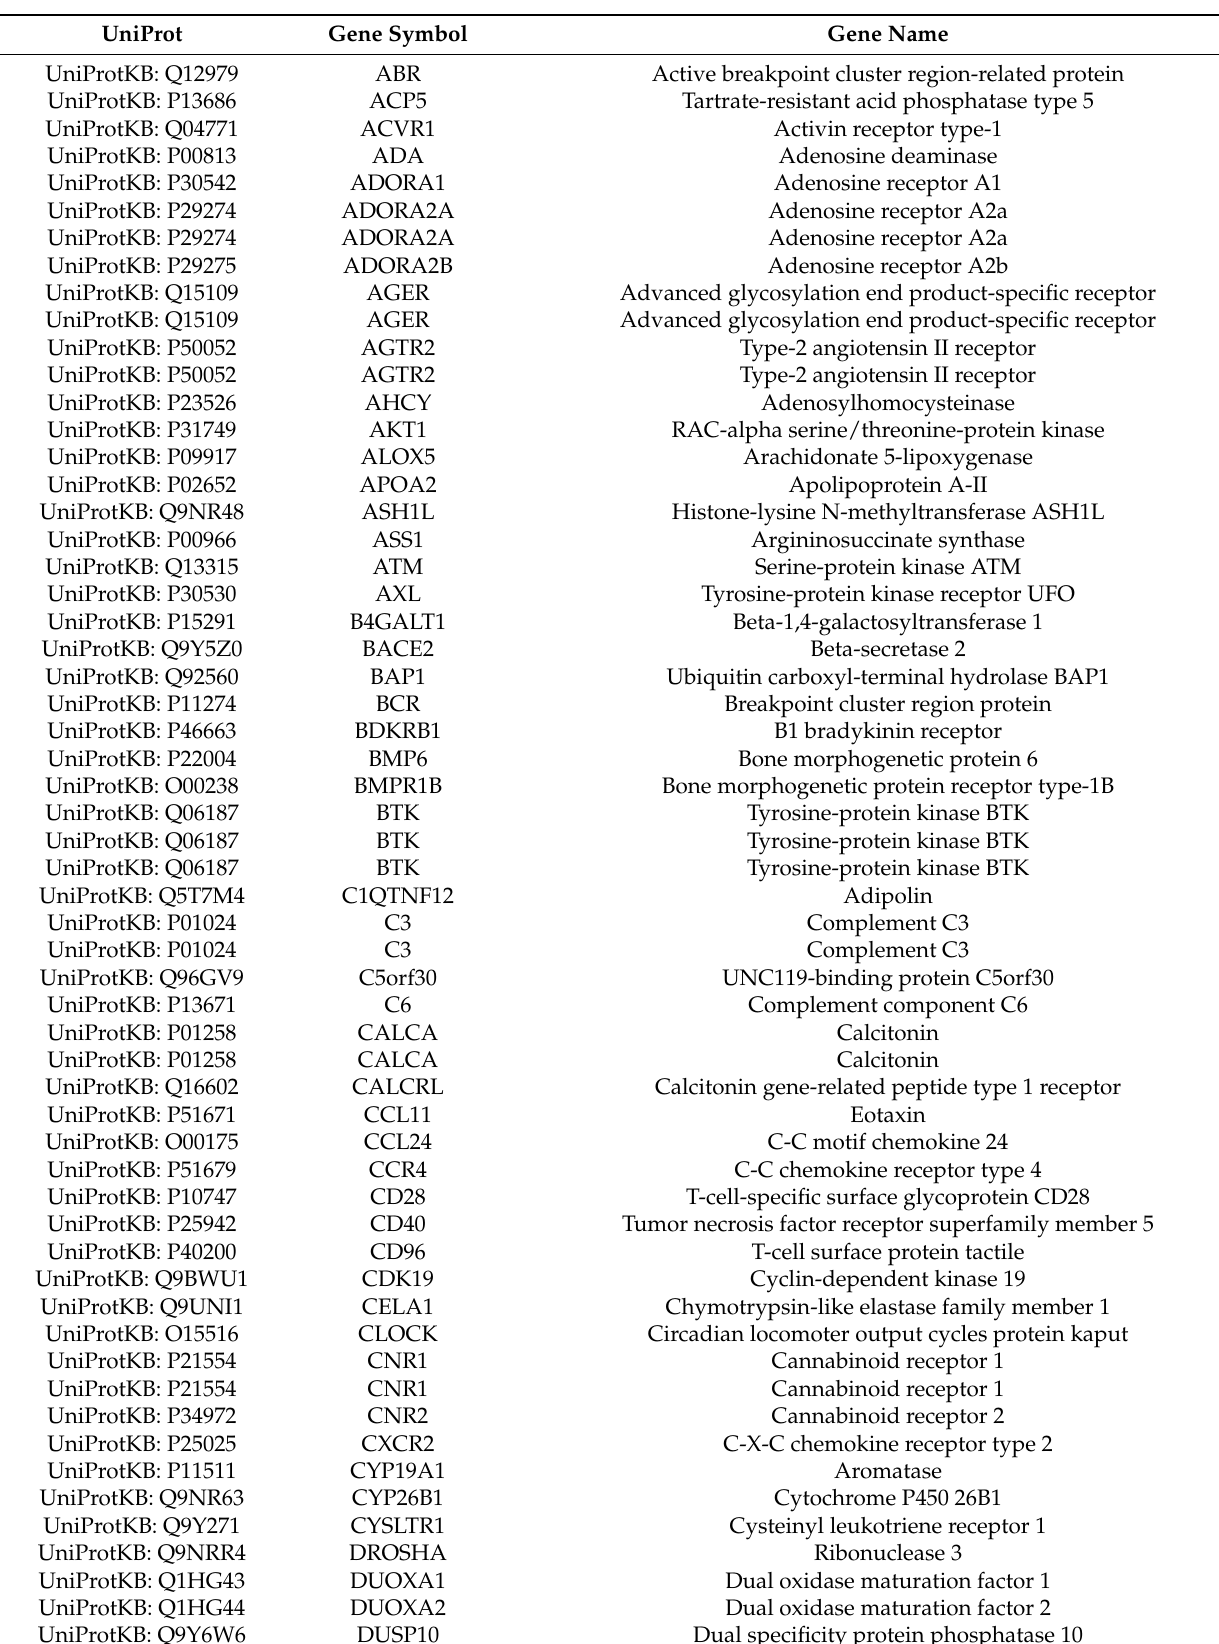
Table 2. List of genes used for calculation of the level of gene expression in inflammation.